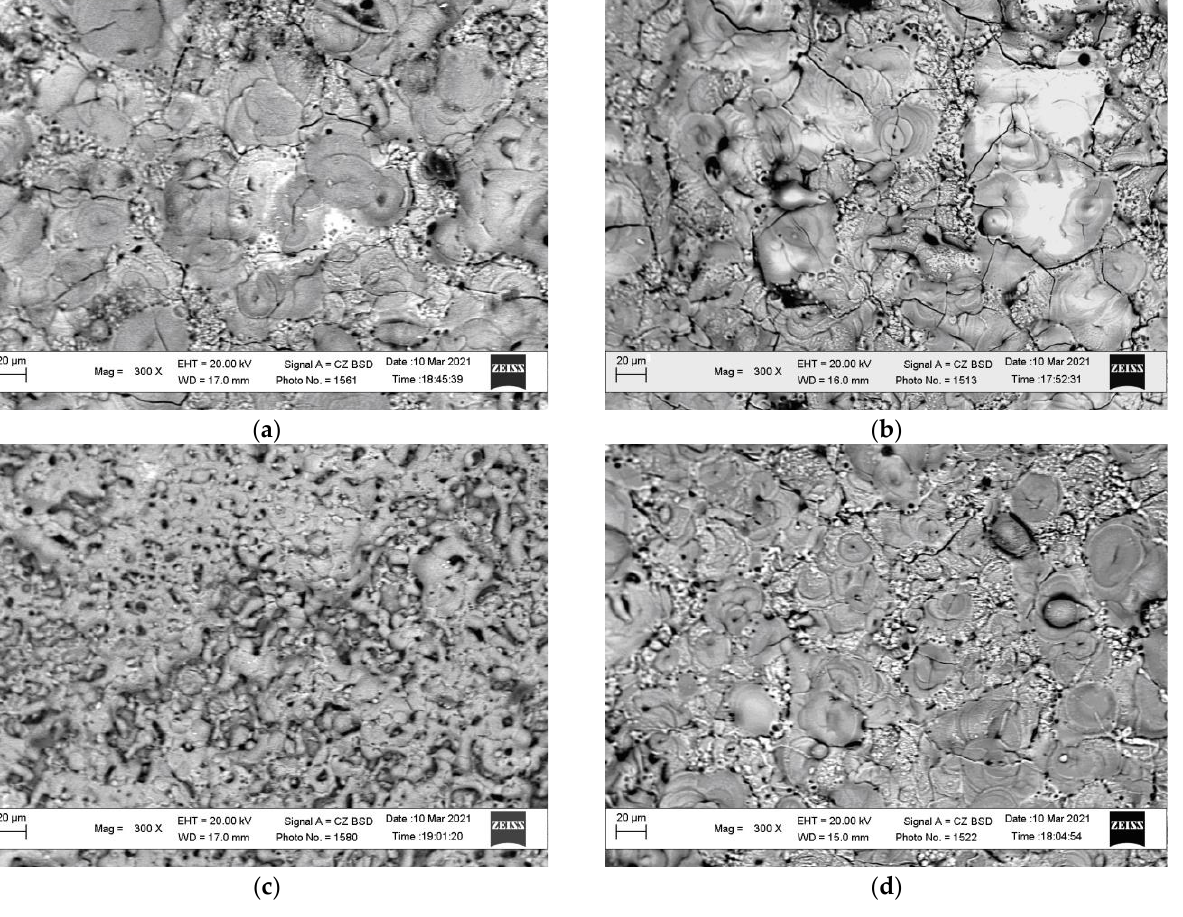
Figure 2. Morphology of the surface of PEO layers on cast alloys AK9 ( a , c ) and AK12 ( b , d ) synthesized in the base electrolyte (aqueous solution of 3 g/L KOH + 2.1 g/L Na 2 SiO 3 ) ( a , b ) and with the addition to the base composition of hydrogen peroxide in the amount of 3 g/L ( c , d ).